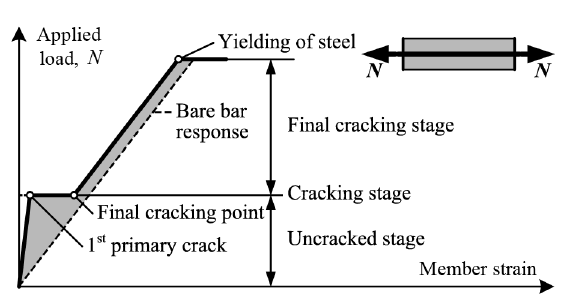
Fig. 2. Idealised loading-deformation response of RC